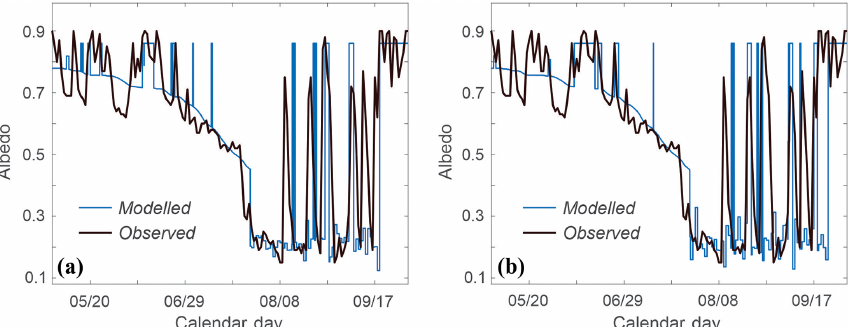
Figure 8. Two realizations of modelled vs. observed surface albedo at the Haig Glacier AWS site, 1 May to 30 September 2007. Summer snow events (albedo spikes) are modelled as random events in the albedo